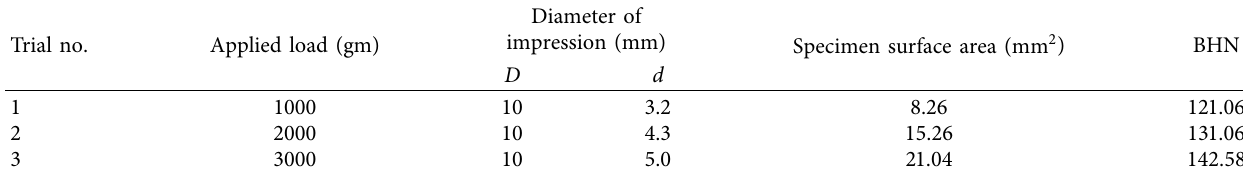
Table 2: Brinell hardness test on AA 2014